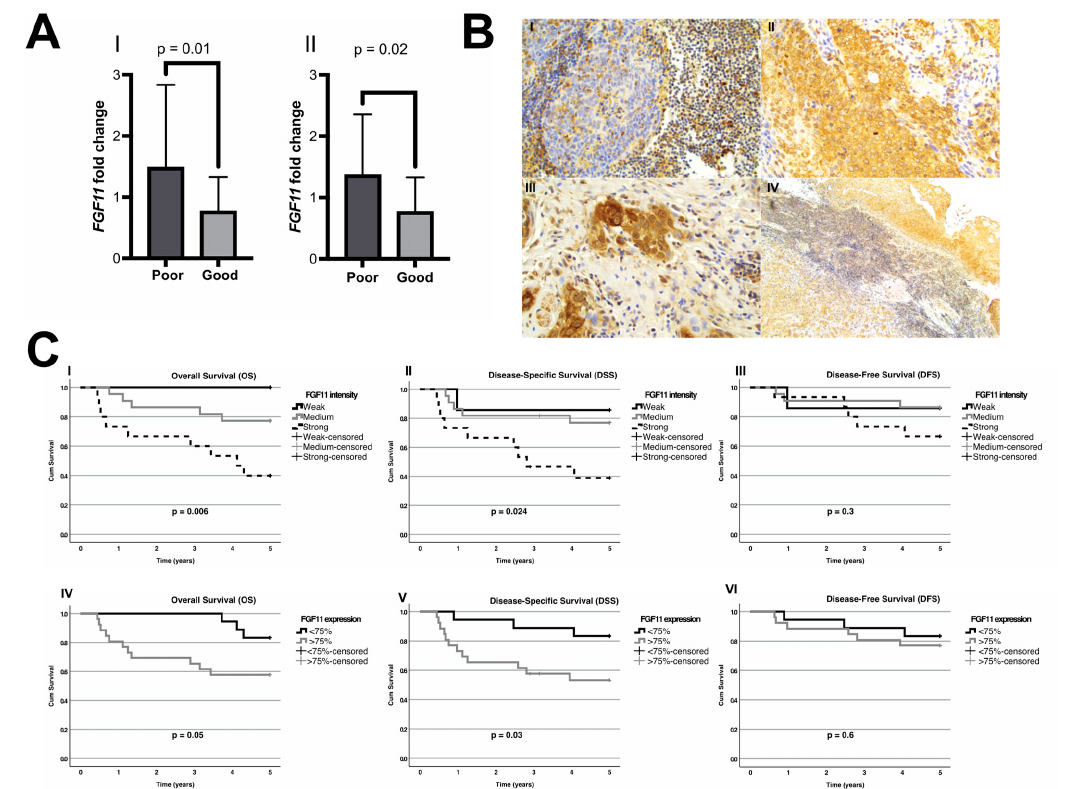
Figure 2. ( A ) Bar graphs (including standard deviation, SD) showing a significant ( p = 0.01 and p = 0.02, respectively) difference in the relative FGF11 gene expression between good and poor survival as determined by qPCR. Plot I: poor survival defined as a locoregional recurrence and/or dead with disease. Plot II: poor survival defined as a locoregional recurrence. ( B ) Microphotographs of examples of FGF11-immunohistochemical staining and their interpretation. I, top left: absence of FGF11 staining in tumour cells with surrounding positive lymphoepithelial tissue and tumour infiltrating lymphocytes. II, top right: moderate cytoplasmic immunoreactivity in tumour cells. III, bottom left: strong cytoplasmic immunoreactivity in tumour cells. IV, bottom right: weak cytoplasmic immunoreactivity in tumour cells, also weaker than in the adjacent normal epithelium. ( C ) Survival curves depicting overall survival (OS), disease-specific survival (DSS), and disease-free survival (DFS) with regard to FGF11 tumour staining intensity (plots I–III) and the proportion of tumour cells expressing FGF11 (plots IV–VI). Patients with a strong FGF11 intensity had a significantly poorer OS and DSS ( p = 0.006 and p = 0.024, respectively). Similarly, patients with a stronger FGF11 intensity tended to have a worse DFS, compared to patients with weak intensity; however, these differences were not statistically significant ( p = 0.3). Moreover, patients with a higher fraction of FGF11 positive cells (>75%) had a significantly worse OS and DSS as compared to patients with a lower fraction